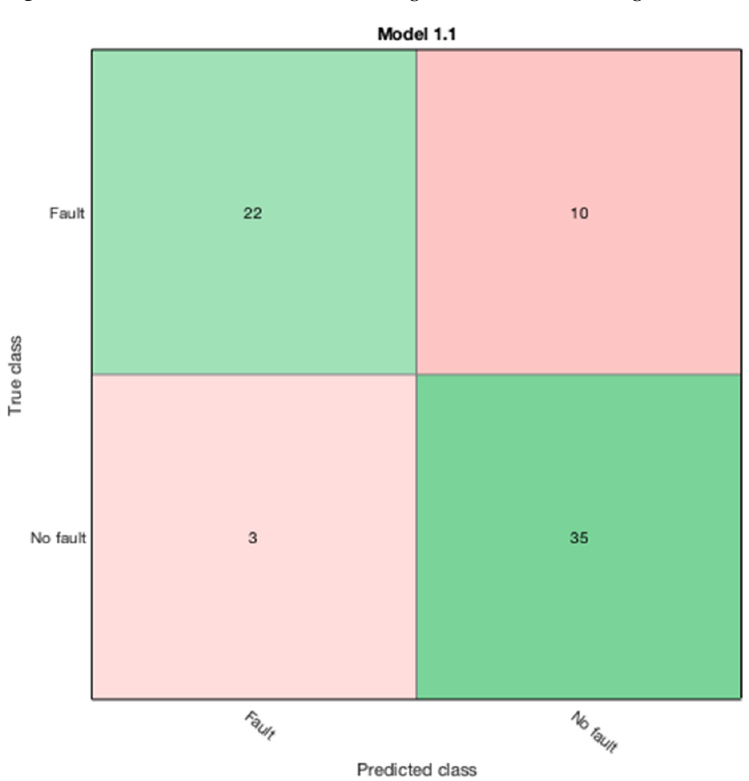
Figure 6. H 2 versus C 2 H 2 . Blue and orange ( • )—raw data, orange and blue ( × )—predicted data. Figure 6. H (cid:2870) versus C (cid:2870) H (cid:2870) . Blue and orange (•)—raw data, orange and blue (×)—predicted data. Table 4. SVM 1 DGA classification outcomes.